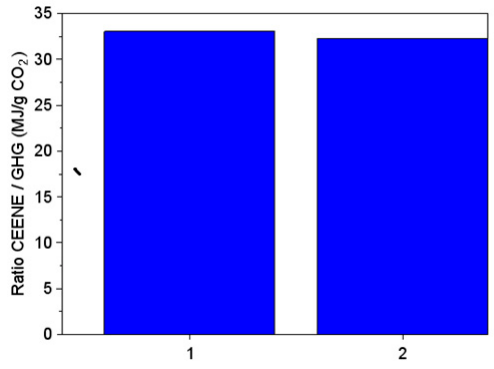
Figure 6. CEENE/GHG emissions relationship alterations for the scenarios.